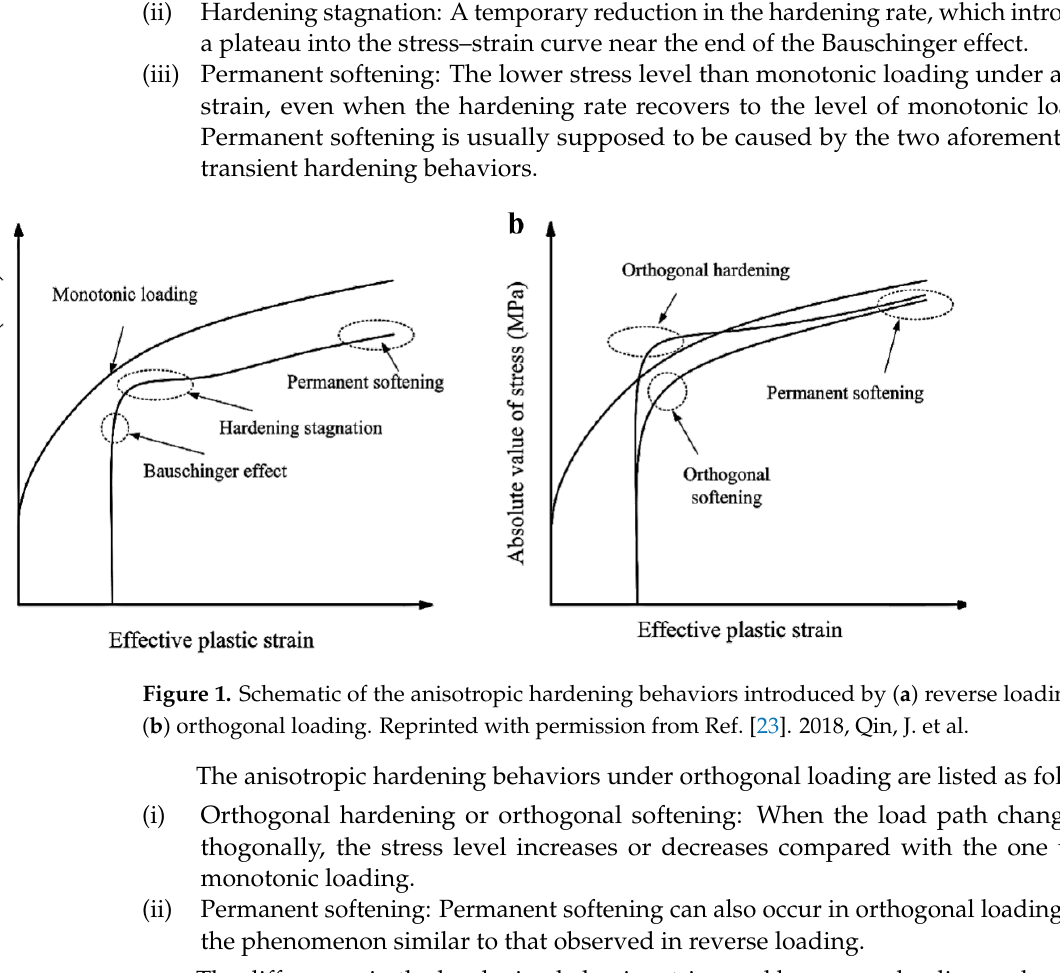
Figure 2. Evolution of the yield surface according to the type of hardening: ( a ) kinematic hardening and ( b ) distortional hardening.